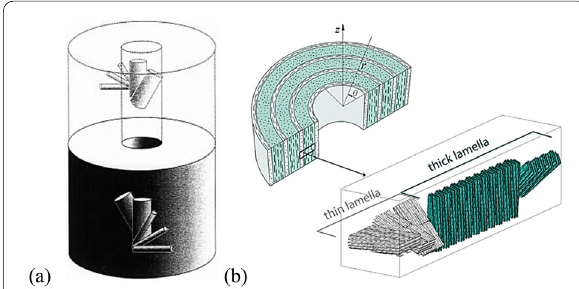
Fig. 1 Microstructure schematic diagram of fiber arrangement in osteon. a Direction of fibers in adjacent sub-lamella and b structure and directions of thin and thick lamellae